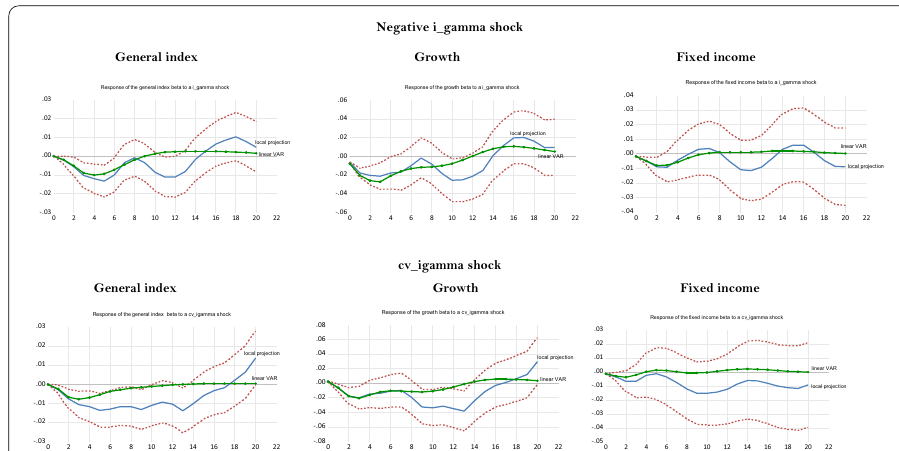
Fig. 5 Local projection of illiquidity shocks on the beta of the general index, growth and fixed income strategies over the subprime crisis with cv_igamma instrumented. Notes: Liquidity shocks are measured by the main series of Pástor and Stambaugh (2003)—i.e., the innovation in aggregate liquidity ( i_gamma )—and its conditional variance as computed by the EGARCH (Nelson 1991) method ( cv_igamma ). The